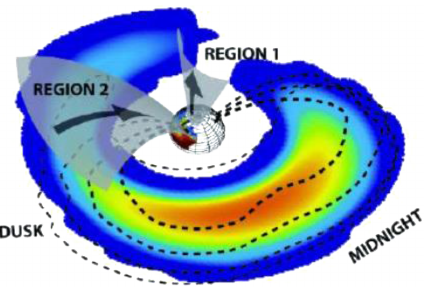
Figure 5. Current systems associated with the partial ring current as deduced from the ENA measurements (Plate 2 from Brandt et al.,